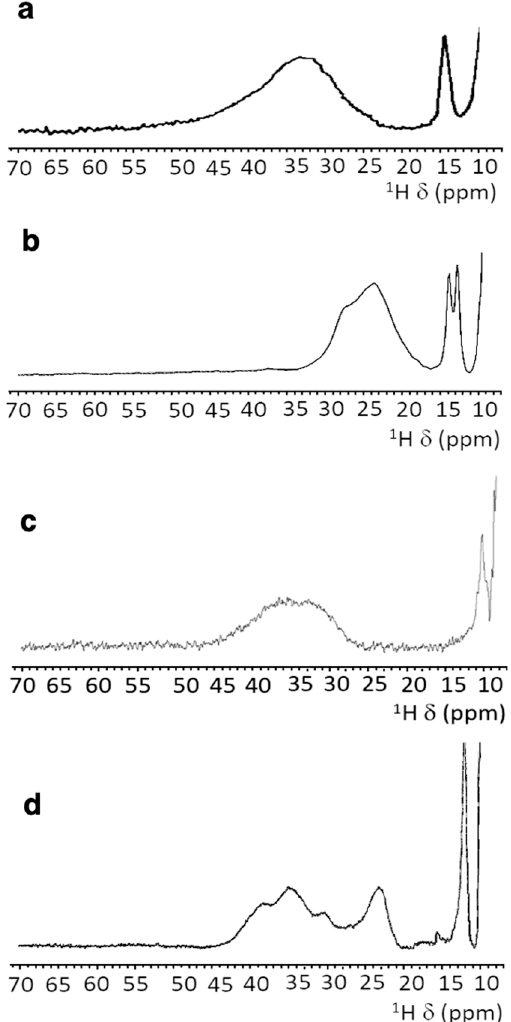
Molecules 2022 , 27 , x FOR PEER REVIEW